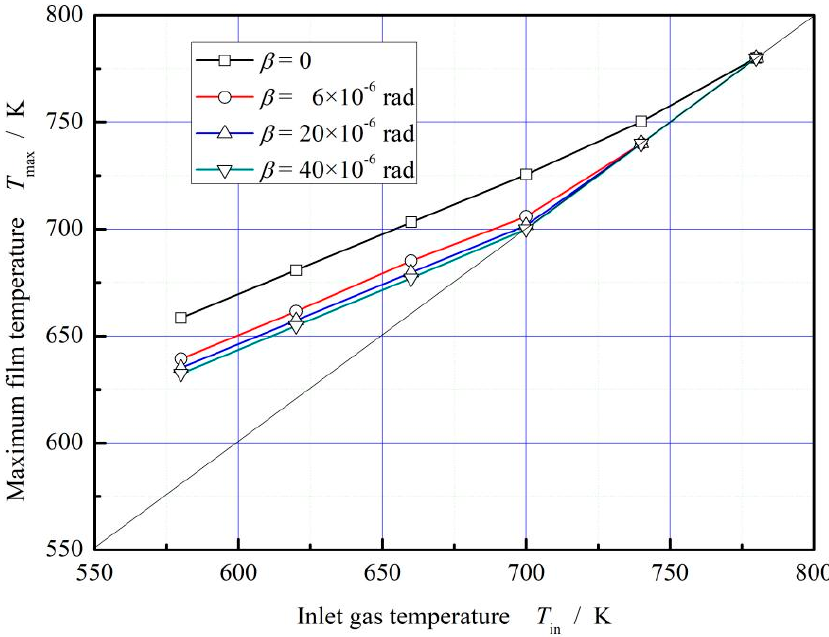
Figure 6. Influence of deflection angle on the maximum film temperature. ( p i = 0.2 MPa, ω = 3.0 × 10 4 r/min, T out = 380 K).